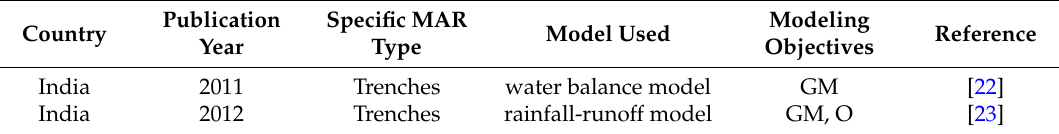
Table 7. Rainwater and Runoff Harvesting modeling studies. The following abbreviations are used for the covered modeling objectives: Groundwater management (GM), Optimization